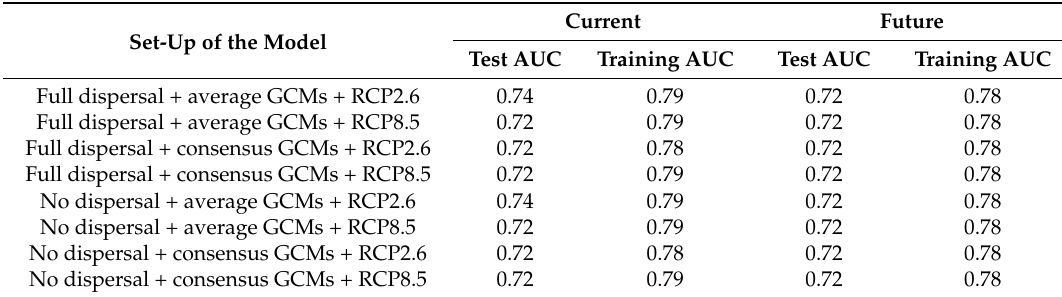
Table 1. The AUC scores for MaxEnt output, in various modeled projections of Sapindus mukorossi distribution in China.